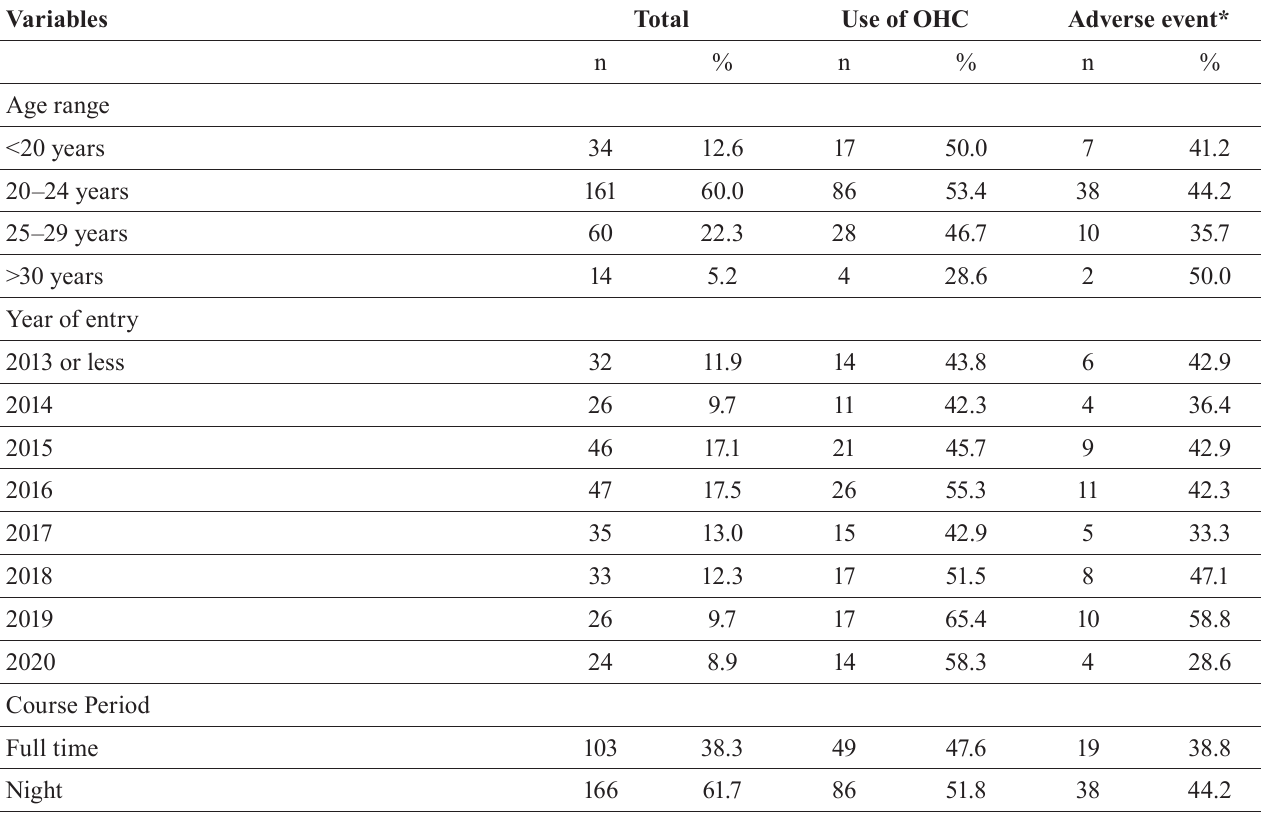
TABLE I - C haracteristics of pharmacy students (n = 269)